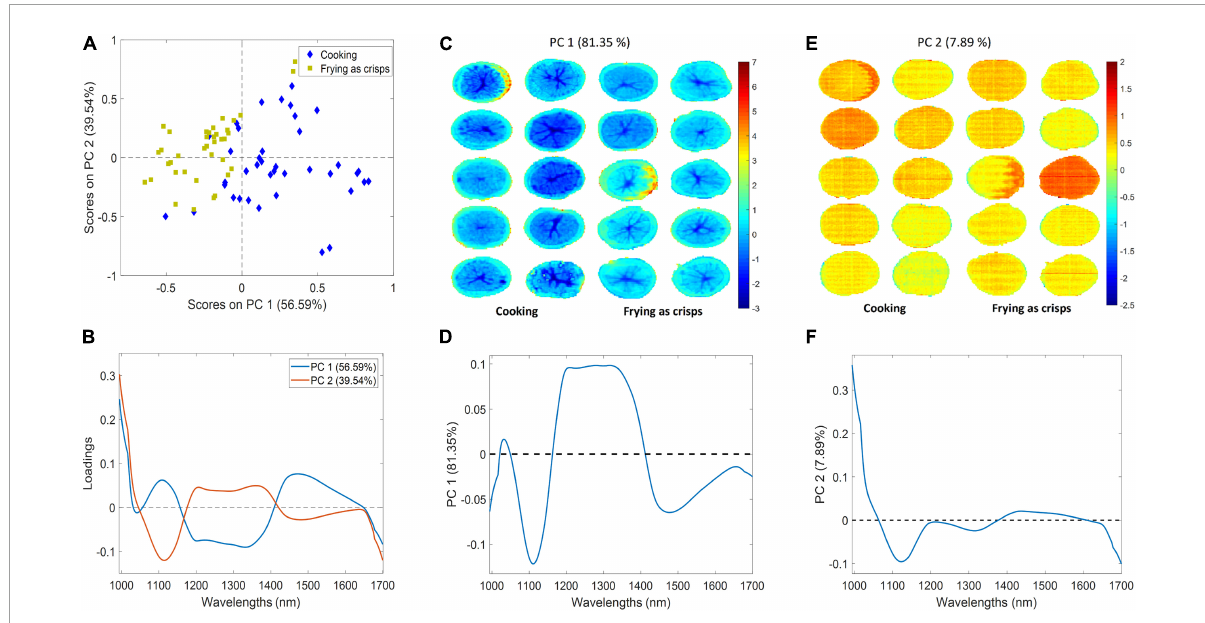
FIGURE4 PCA models. Score (A) and the corresponding loading (B) plot from the first two PCs of the PCA using the mean spectra of all samples. Score (C) and corresponding loading of PC 1 (D) ; score (E) and corresponding loading of PC 2 (F) of the PCA model using the individual pixel spectra of each tuber of the calibration dataset. Explained variance of each PC is indicated in